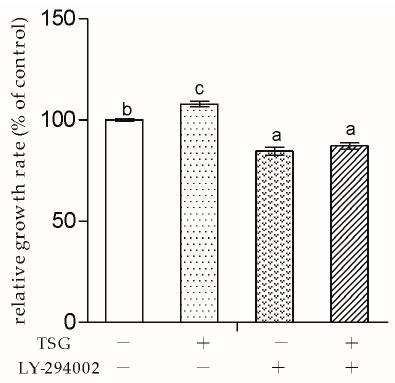
Figure 7. Effect of TSG and LY-294002 on the viability of the MC3T3-E1 cells. Data are represented as the mean ± SD of four determinations. Different letters indicate significant differences ( p < 0.05).